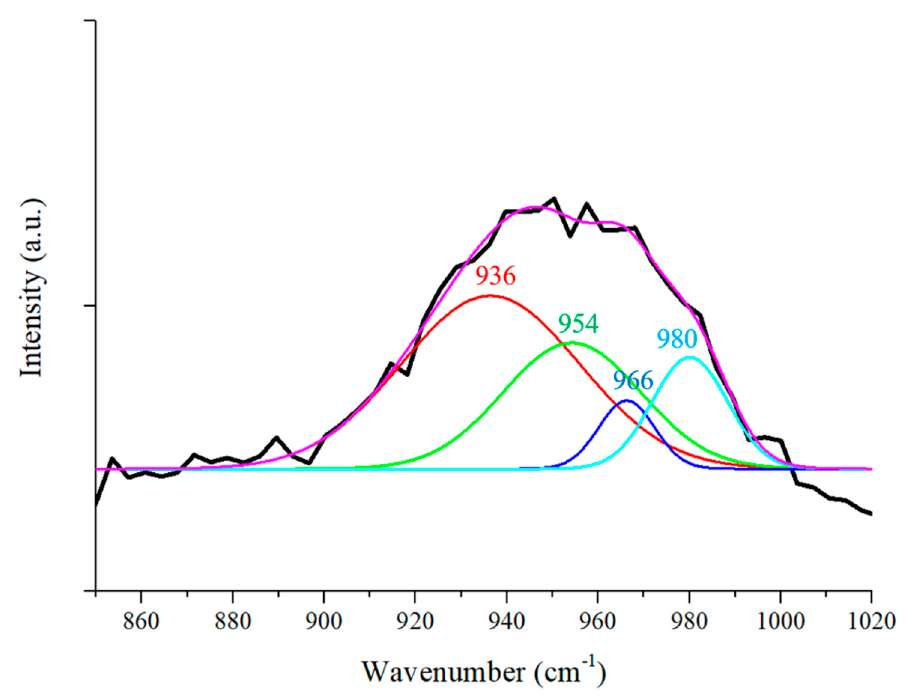
Figure 8. Gaussian curve fitting of the Raman Peak at 957 cm − 1 in Figure 7c. Peaks 936, 954, and 988 cm − 1 correspond to Si. The Raman band at 966 cm − 1 is attributed to Raman scattering of SiC.